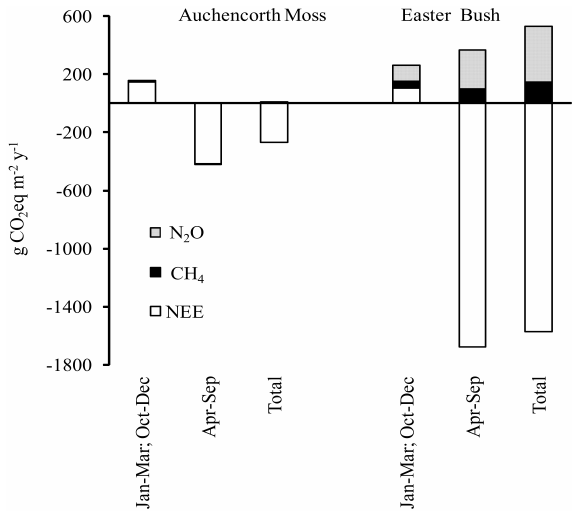
Fig. 7. Greenhouse gas budgets for the semi-natural moorland Auchencorth Moss and the intensively grazed grassland Easter Bush. Data are averages over 4yr (Total) and split into the pe- riod when NEE CO 2 was small or positive (January–March and October–December) and the net ecosystem exchange of CO 2 (NEE) uptake period (April–September). At Auchencorth Moss N 2 O fluxes are too small to be visible and the small CH 4 fluxes are only visible as a slightly thicker black